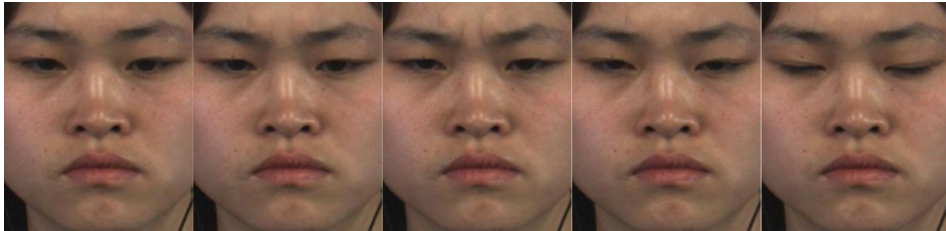
Figure 1. Sample frames showing Subject 11’s micro-expression clip ‘EP19_03f’ that was coded as an AU4 in the ‘others’ category ( c (cid:13) Xiaolan Fu).